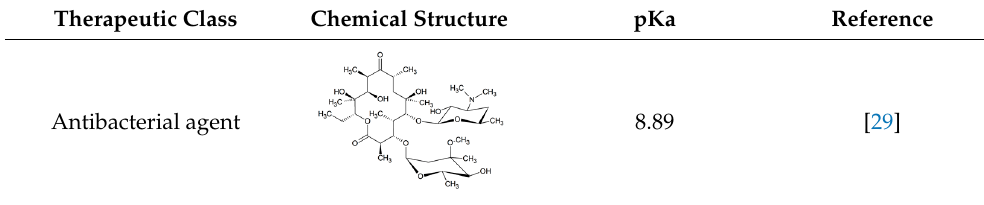
Table 1. Physicochemical properties and chemical structure of erythromycin. Therapeutic